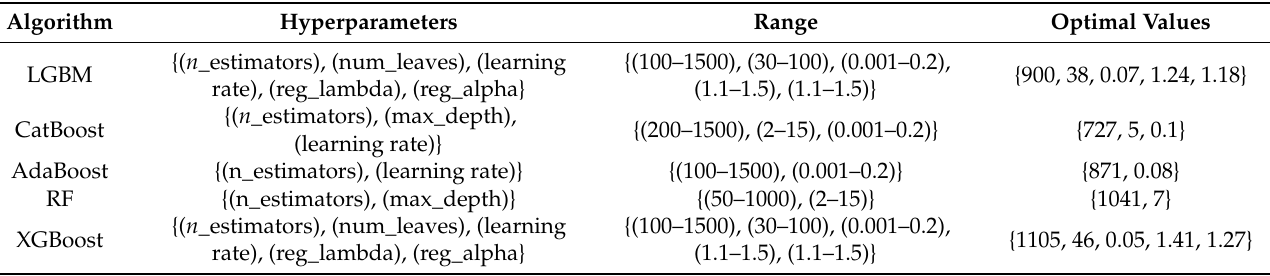
Table 2. Hyperparameter tunings of ELCs.